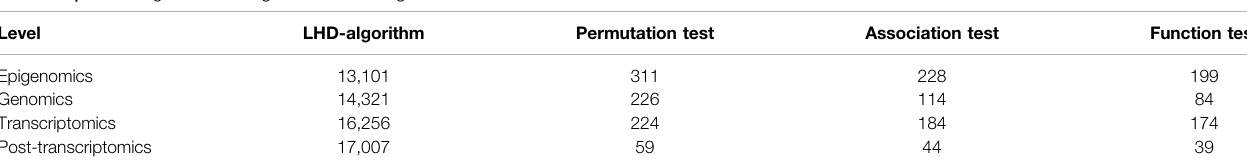
TABLE 1 | Remaining latent driver genes at each stage of LHD-based